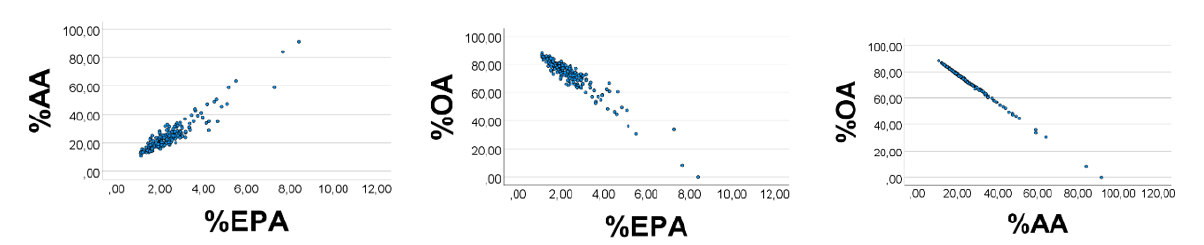
Figure 6. Associations between relative amounts of EPA ’ , AA ’ , and OA ’ , in a computer experiment using RANDOM numbers in lieu of fatty acid values reported in human sera [31]. S = OA ’ + EPA ’ + AA ’ . RANDOM numbers ( n = 200) with true mean values were used, but with variabilities like the ones found in a homogeneous chicken population (33), i.e., CV being 44% for OA, and 10% for AA and EPA. The mean (SD) values used were: 1323 (582) for OA ’ , 402 (40) for AA ’ , and 39 (4) for EPA ’ . %AA ’ vs. %EPA ’ : rho = 0.887; %OA ’ vs. %AA ’ (%EPA ’ ): rho = −0.999 (−0.905), p < 0.001 for all, n = 200. Note: In the figure we have omitted the random number mark ( ‘ ) on the variables.